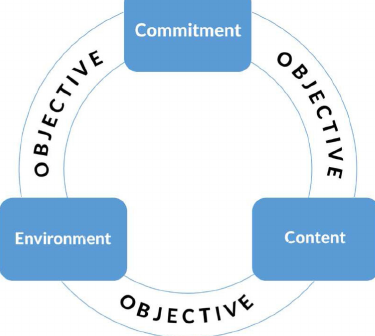
FIG. 1. Diagram showing the 4 factors needed for implement- ing a successful AC and how they are connected with each